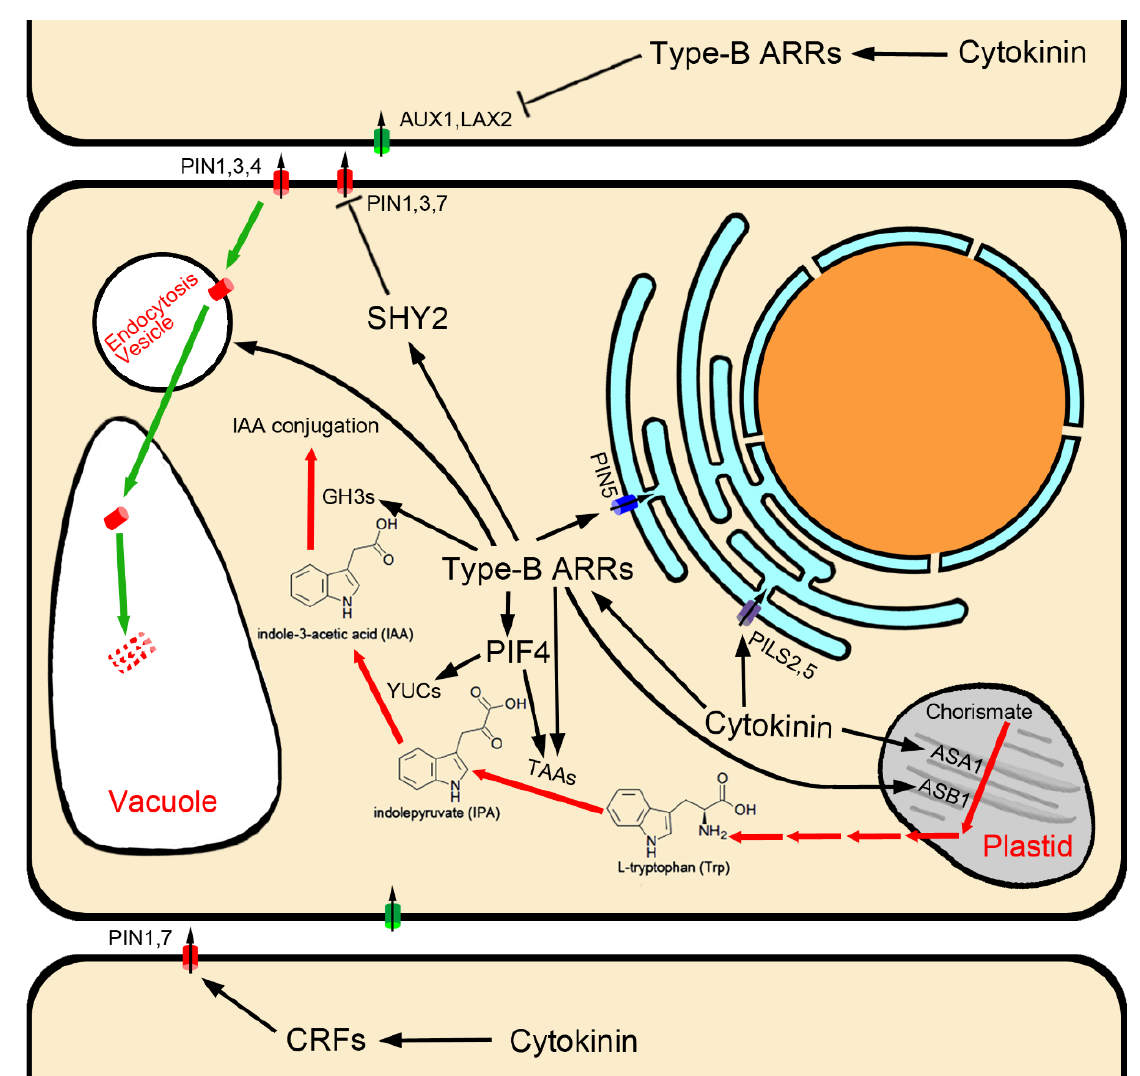
Figure 1. Auxin biosynthesis/metabolism and transport regulated by cytokinin.